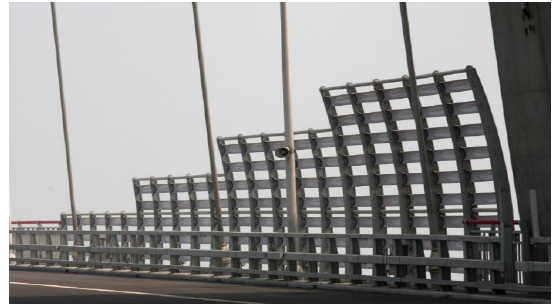
Figure 20. The final arrangement scheme of wind barriers on Sutong Bridge.